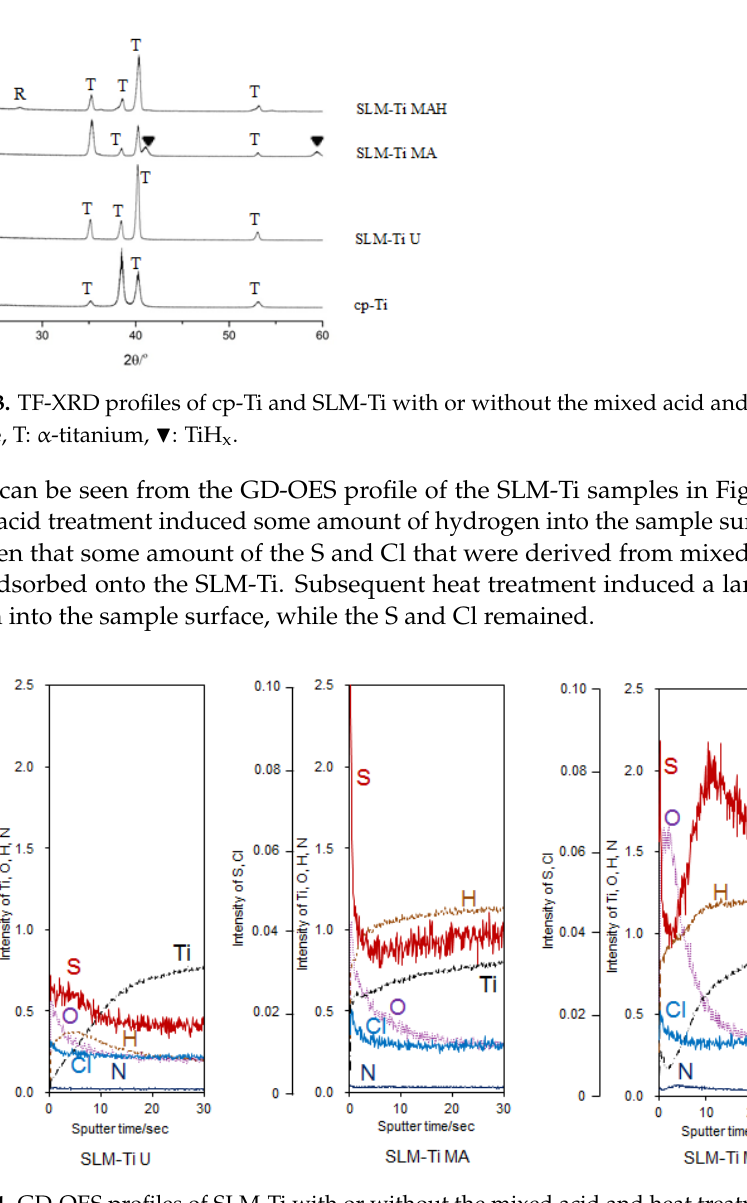
Figure 5. SEM images of cp-Ti and SLM-Ti after soaking in SBF for 1 day. Inserted window shows high magnification image. Only SLM-Ti MAH was subsequently covered by the apatite layer. 3.3. Cell Morphology There are critical differences in cell morphology between cp-Ti and SLM-Ti. The cells on cp-Ti were round in shape, while on SLM-Ti they were elongated and bridged the cor- ners, even after incubation periods of 0.5 h. Although the elongation on untreated SLM- Ti was not increased by prolongation of the incubation periods up to 24 h, it was further increased by the mixed acid and subsequent heat treatment, as shown in Figure 6. 1 µm